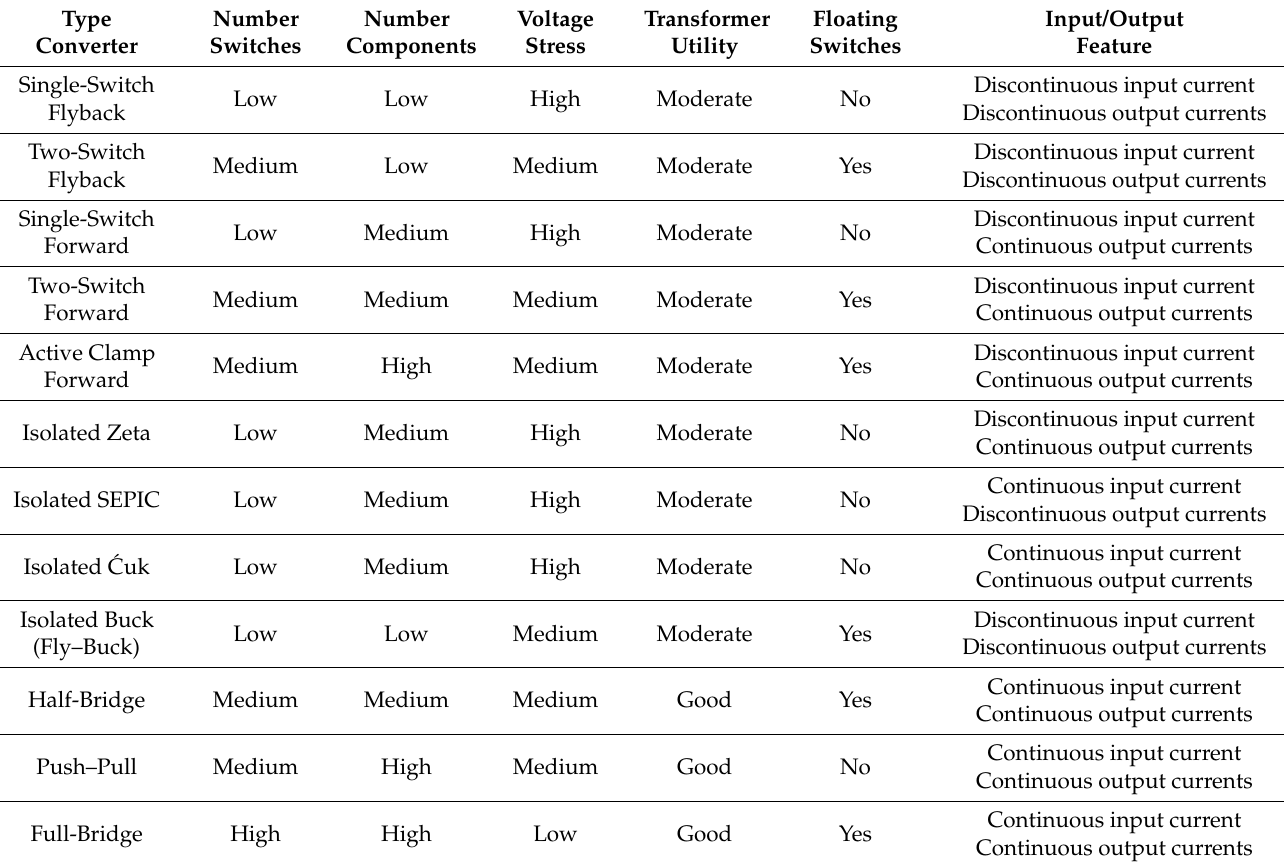
Table 2. Comparative summary of SIMO Isolated DC–DC